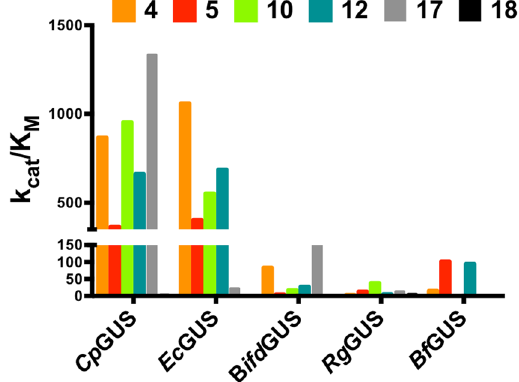
Figure 1. Cp GUS and Ec GUS exhibit higher catalytic efficiency (k cat /K M ) than do the other GUSs. Comparison of k cat /K M values of the five bacterial GUSs used in this study for substrates 4 , 5 , 10 , 12 , 17 , and 18 indicating the superior catalytic efficiency of Cp GUS and Ec GUS compared with Rg GUS, Bf GUS, and Bifd GUS. See also Supplementary Tables S1 and S2 for the kinetic parameters, and Fig. 2h for the molecular structures of the